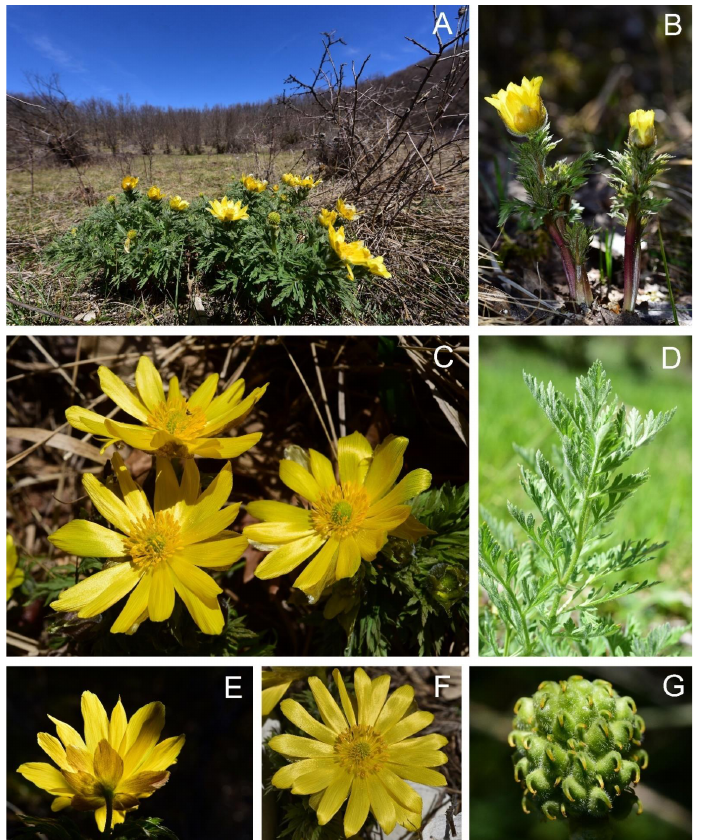
Figure 7. Adonis fucensis F.Conti & Bartolucci [Italy, Abruzzo, Mt. Annamunna, photo by F. Conti ( A – E , G ) and ( F ). Bartolucci (F)]. ( A ) Habitat and flowering plants of A. fucensis ; ( B ) whole plants; ( C ) flowering plants; ( D ) cauline leaf; ( E ) flower, dorsal view; ( F ) flower, front view; ( G ) not mature aggregate fruit.